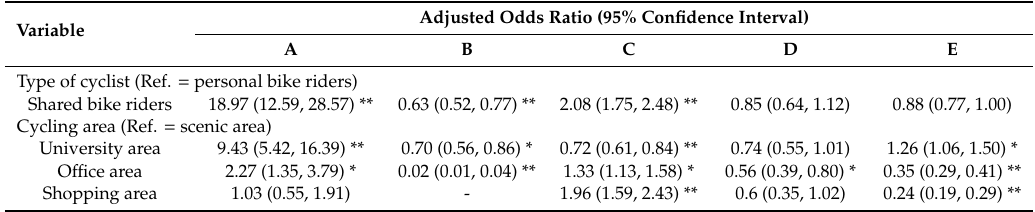
Figure 2. Incidence of unsafe cycling behaviors in four cycling areas in Changsha, China. Note: A: not wearing a helmet, B: cycling through a red light, C: riding in opposite direction of tra ffi c, D: not holding the handlebar with both hands, E: riding on motorway or sidewalk. Behavior B was not observed in the shopping area. *: p < 0.05. **: p < 0.01. Table 2. Associations between unsafe cycling behaviors and both type of cyclist and type of cycling area in Changsha, China ( n =